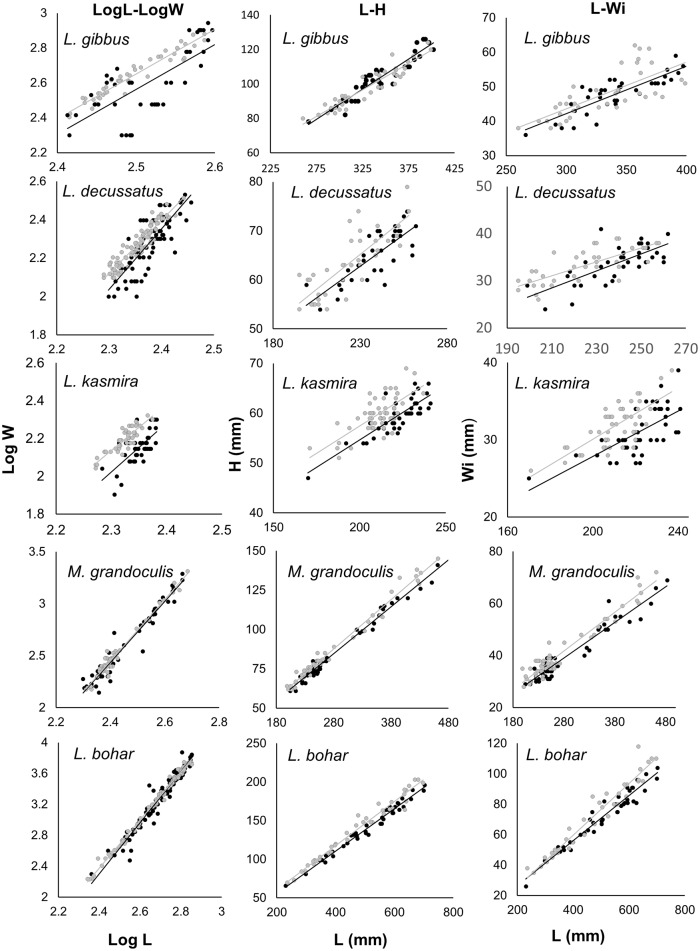
Regressions of Log length (Log L) on Log weight (Log W), Length (L) on height (H) and Length (L) on width (Wi) for L. gibbus, L. decussatus, L. kasmira, M. grandoculis and L. bohar at the Scott Reefs (grey) and the Rowley Shoals (black).Differences in the regression lines between species might be obscured due to variation in the range of the axes. See Table C in
S1 File for statistics.